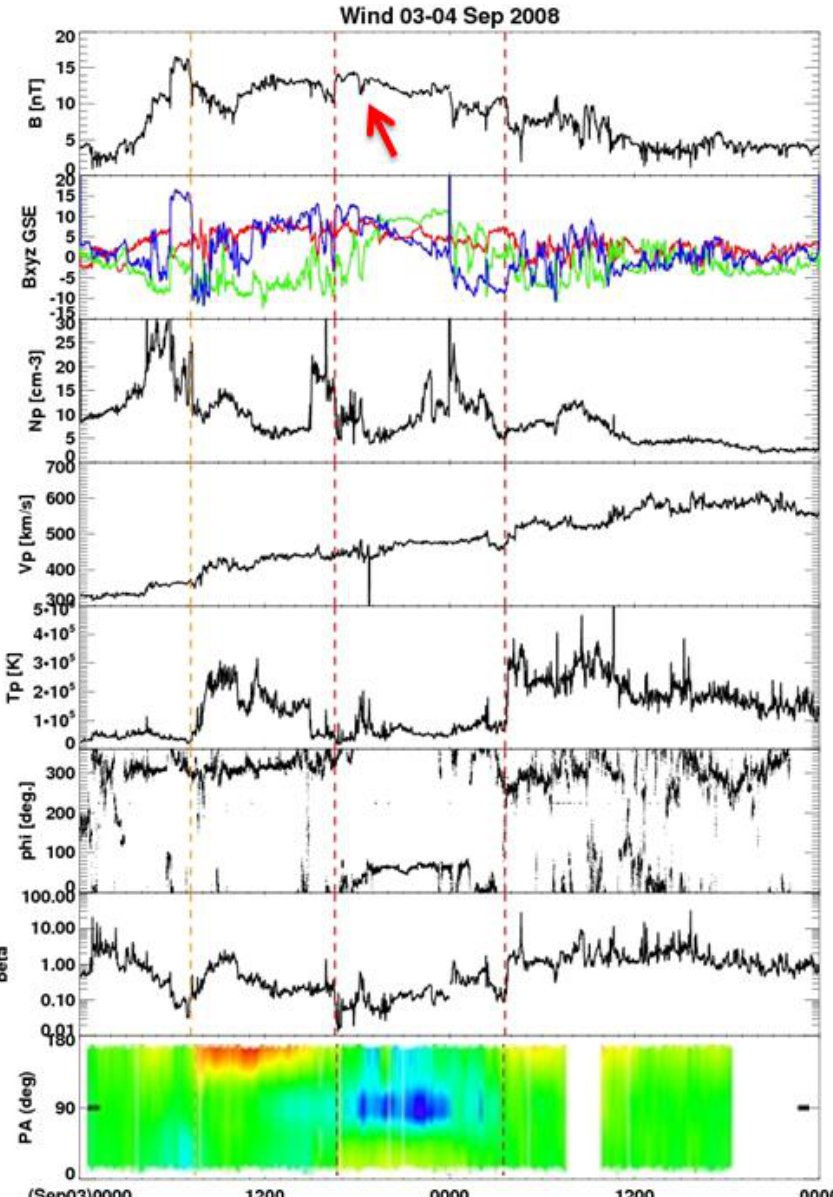
Fig. 1. Wind spacecraft observation of the stream interface (SI) depicted by the orange dashed line and magnetic cloud (MC) depicted by the red dashed lines. Panels from the top: total magnetic field ( B [nT]), components of the interplanetary magnetic field in the GSE coordinate system, plasma density (Np [cm − 3 ]), solar wind speed (Vp [kms − 1 ]), proton temperature (Tp [K]), angle φ (deg.), beta parameter, and the last panel gives the electron pitch angle spectrograms for the low-energy Electron Electrostatic Analyzer (EESA-L) on the 3DP of Wind instrument energy channel 249eV. The color coding indicates the amplitude of the distribution functions in units of s3 km − 3 cm − 3 . The red arrows illustrate the time of the small substructure.